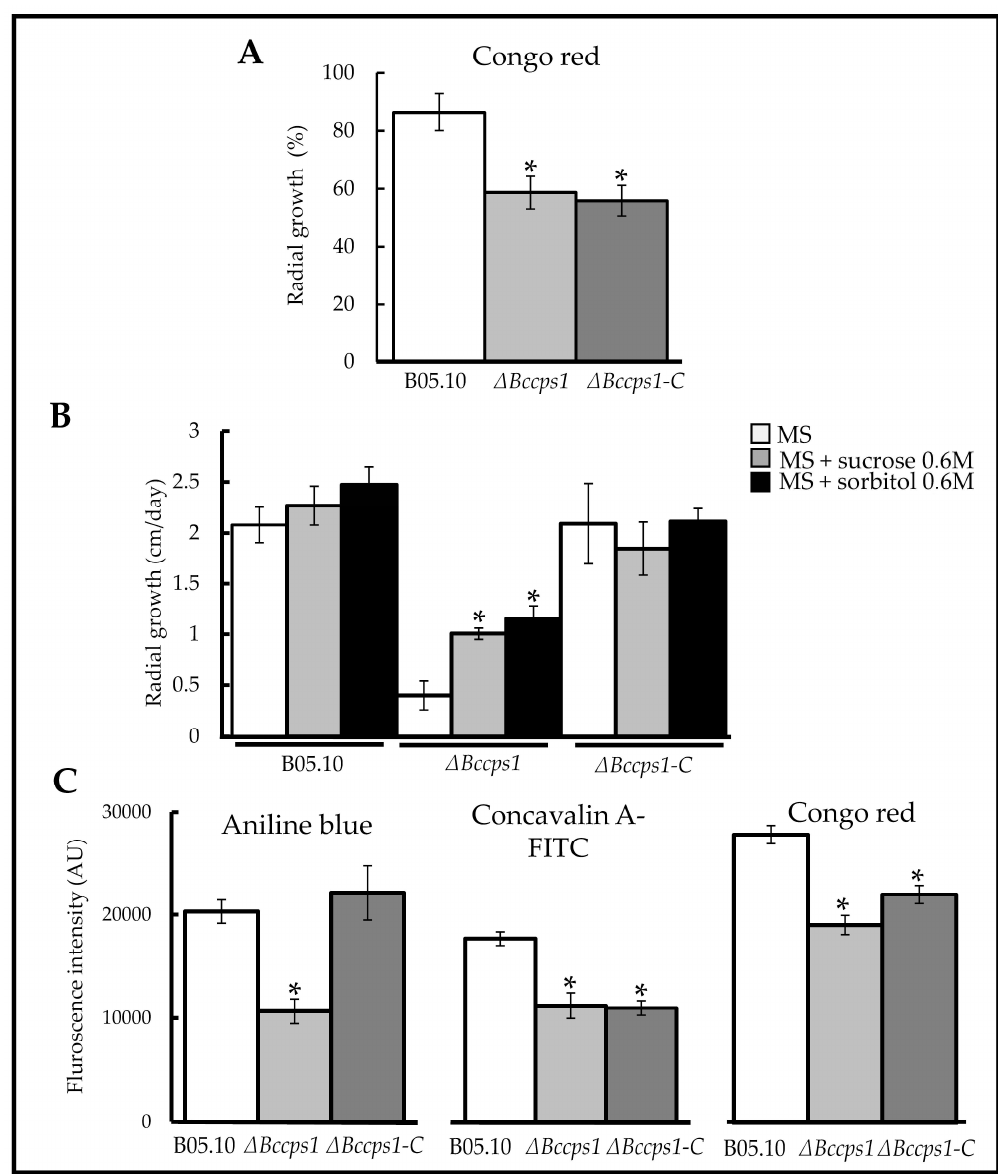
Figure 5. BcCps1 is involved in cell wall integrity and influences cell wall composition. ( A ) Sensitivity of mycelial growth to Congo red in the parental (B05.10), mutant ( Δ Bccps1 ) and complemented ( Δ Bccps1 -C) strains. 100% corresponds to a radial growth of 2.2 cm per day. ( B ) Impact of 0.6 M saccharose (grey) and 0.6 M sorbitol (black) on the mycelial expansion of the B05.10, Δ Bccps1 and Δ Bccps1 -C strains inoculated onto a rich medium (white). ( C ) Cell walls reactivity to anilin blue ( β -1,3-glucan marker), ConcavalinA-FITC (glycoproteins marker) and Congo red (marker of chitin, some glucans and amyloid proteins) in the parental, mutant and complemented strains. Means and standard deviations were calculated from three ( A , B ) or six ( C ) independent experiments ( n = 9 ( A , B ) or n = 17 ( C )). Stars indicate significant differences ( T -test bilateral; p < 0.01).